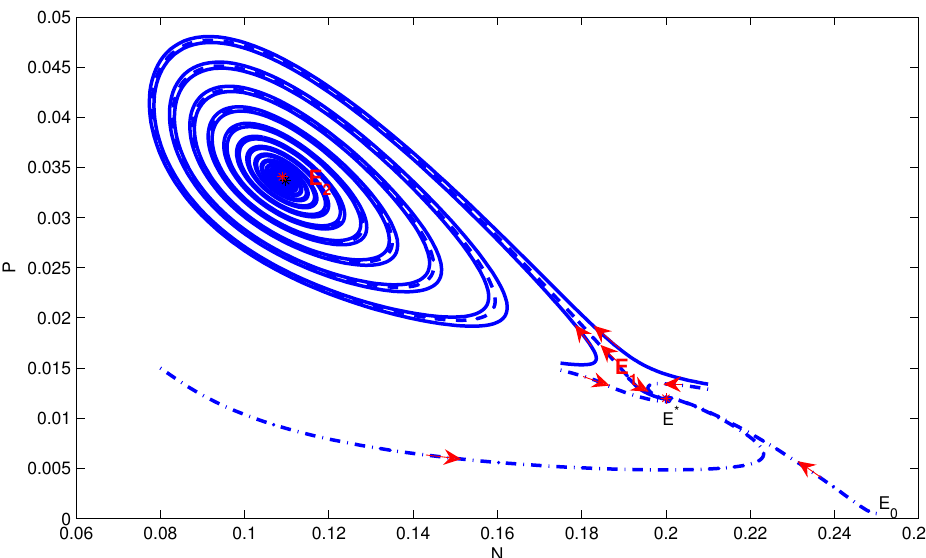
Figure 8. The phase portrait of model Equation (3) with positive stable equilibria E ∗ and E 1 , and unstable equilibria E 0 and E 2 .